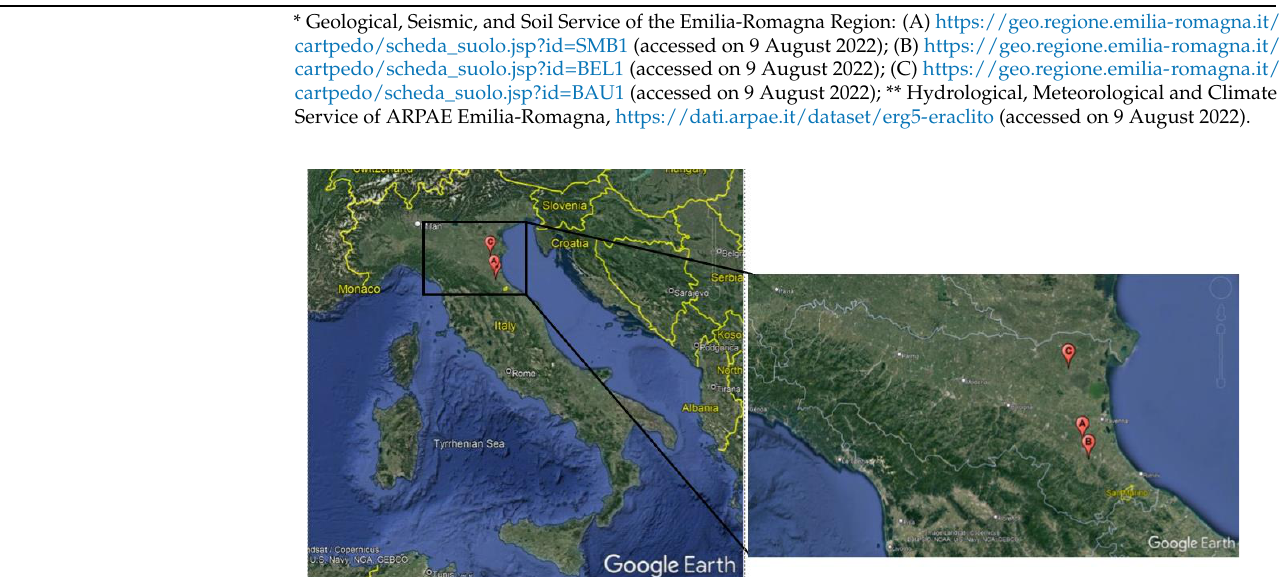
Figure 1. Geographical location of the three plantation sites (A, B, and C) analyzed in the present work.